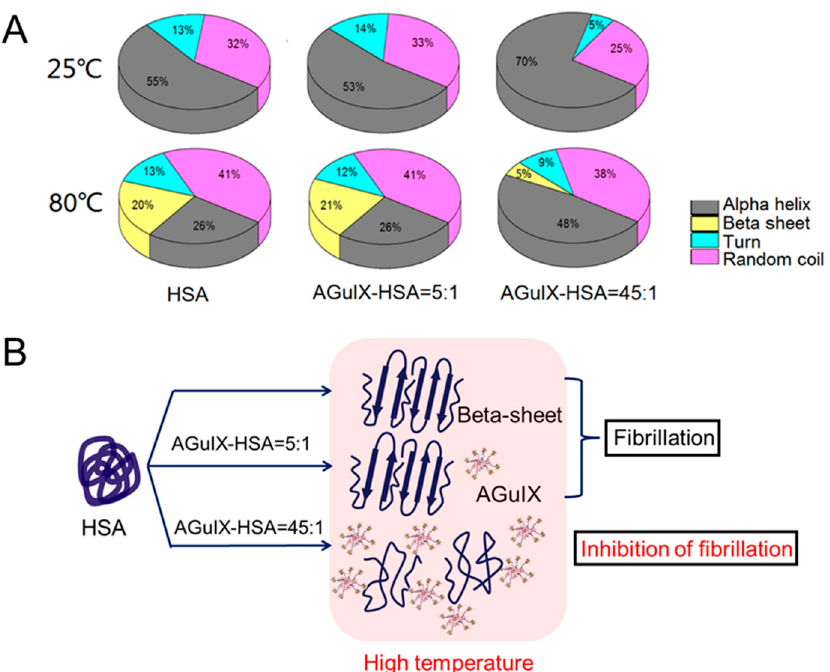
Figure 4. ( A ) Contribution of the respective secondary structures: alpha helix (gray), beta sheet (yellow), turn (cyan), and random coil (magenta) in pure HSA, AGuIX ® :HSA = 5:1 and AGuIX ® :HSA = 45:1, at 80 ◦ C (top) and 25 ◦ C (bottom). ( B ) Scheme of AGuIX ® interacting with HSA at high temperature (80 ◦